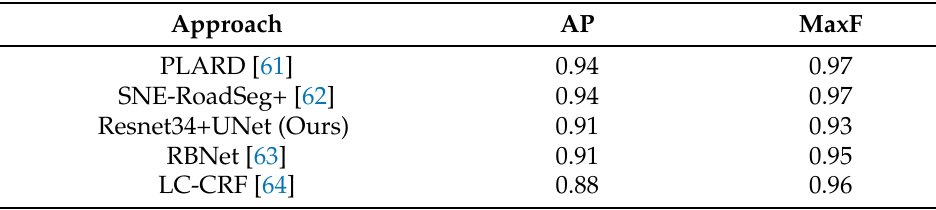
Figure 7. Results of road segmentation on the augmented dataset. The first column shows the input images, while the second and third columns show the ground truth masks and predicted segmentation masks overlapped on the input image, respectively. Table 6. Results on the KITTI road benchmark [60] sorted by Average